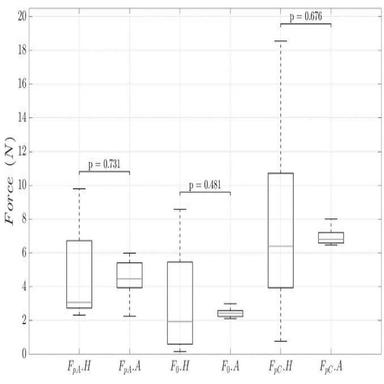
Physical model (polynomial shape function) parameters FpA, F0 and FpC obtained from human specimens (.H) and patient phantom (.A) measurements; p-values as statistical test results above the groups.